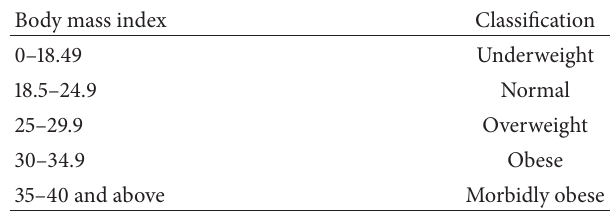
Table 1: World Health Organization body mass index